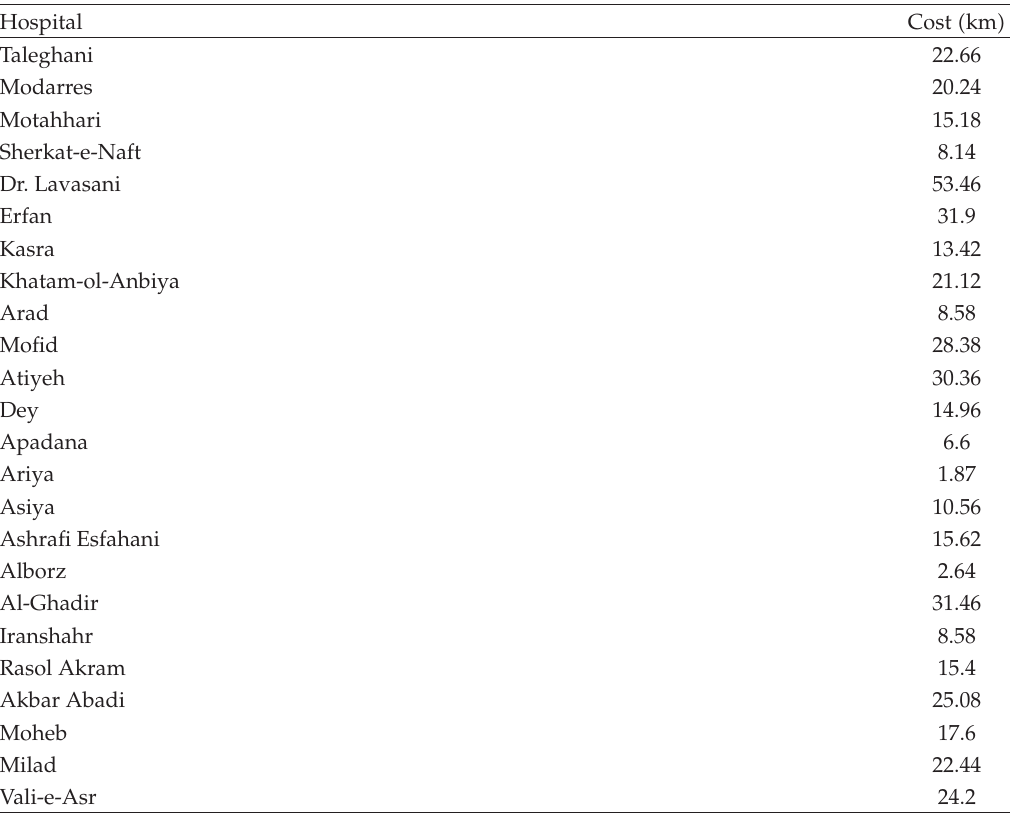
Table 10: Cost of each hospital maintaining its